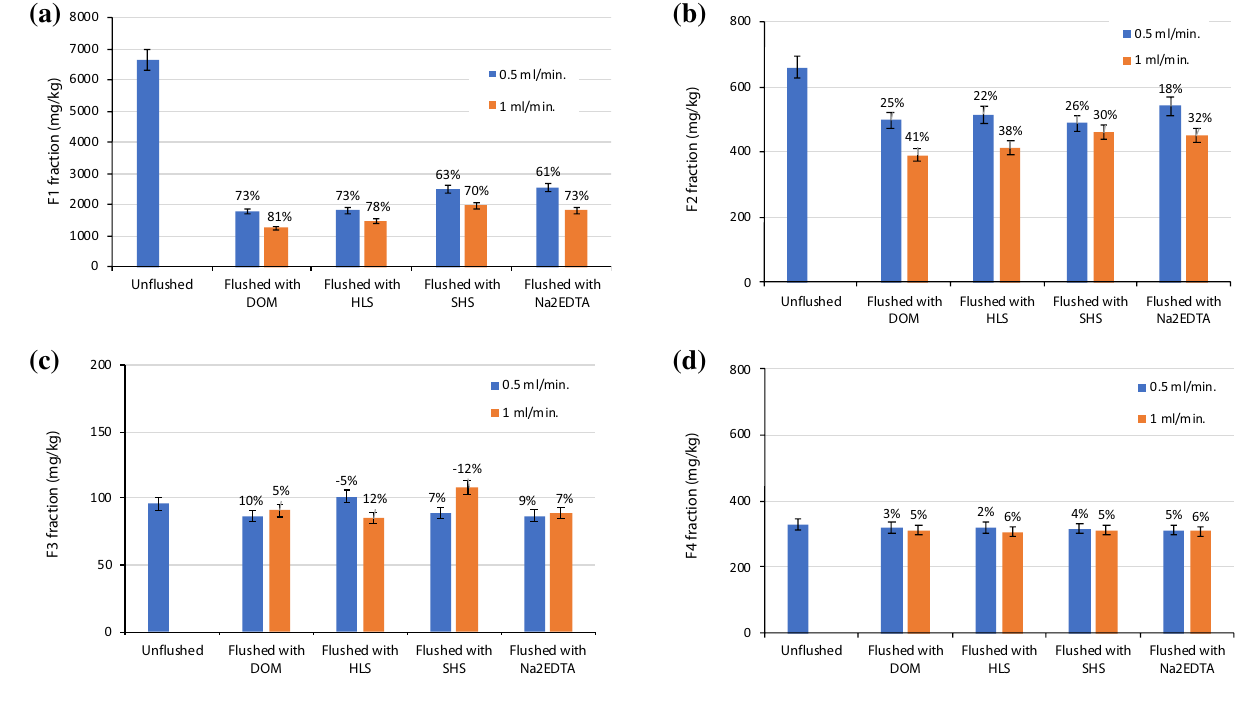
Figure 8. Changes in Cu distribution in unflushed soil and soil flushed with DOM, HLS, SHS and Na 2 EDTA at two flow rates. The values above the bars mean the removal efficiency of Cu from individual fractions: ( a ) F1 fraction, ( b ) F2 fraction, ( c ) F3 fraction, ( d ) F4 fraction. Data are expressed as mean values (n = 2) ± standard deviation error bars.